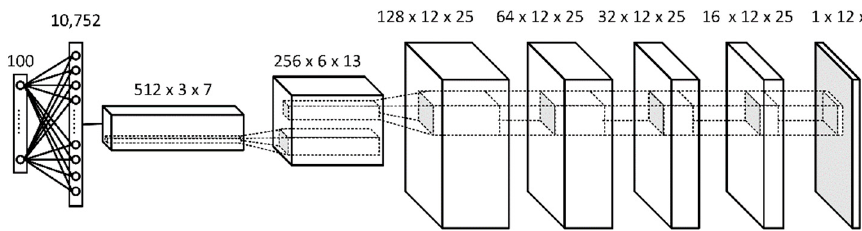
Figure 8. Data rearrangement: a one-dimensional sequence ( 1 × 300 ) is folded into a two-dimensional vector ( 12 × 25 ).